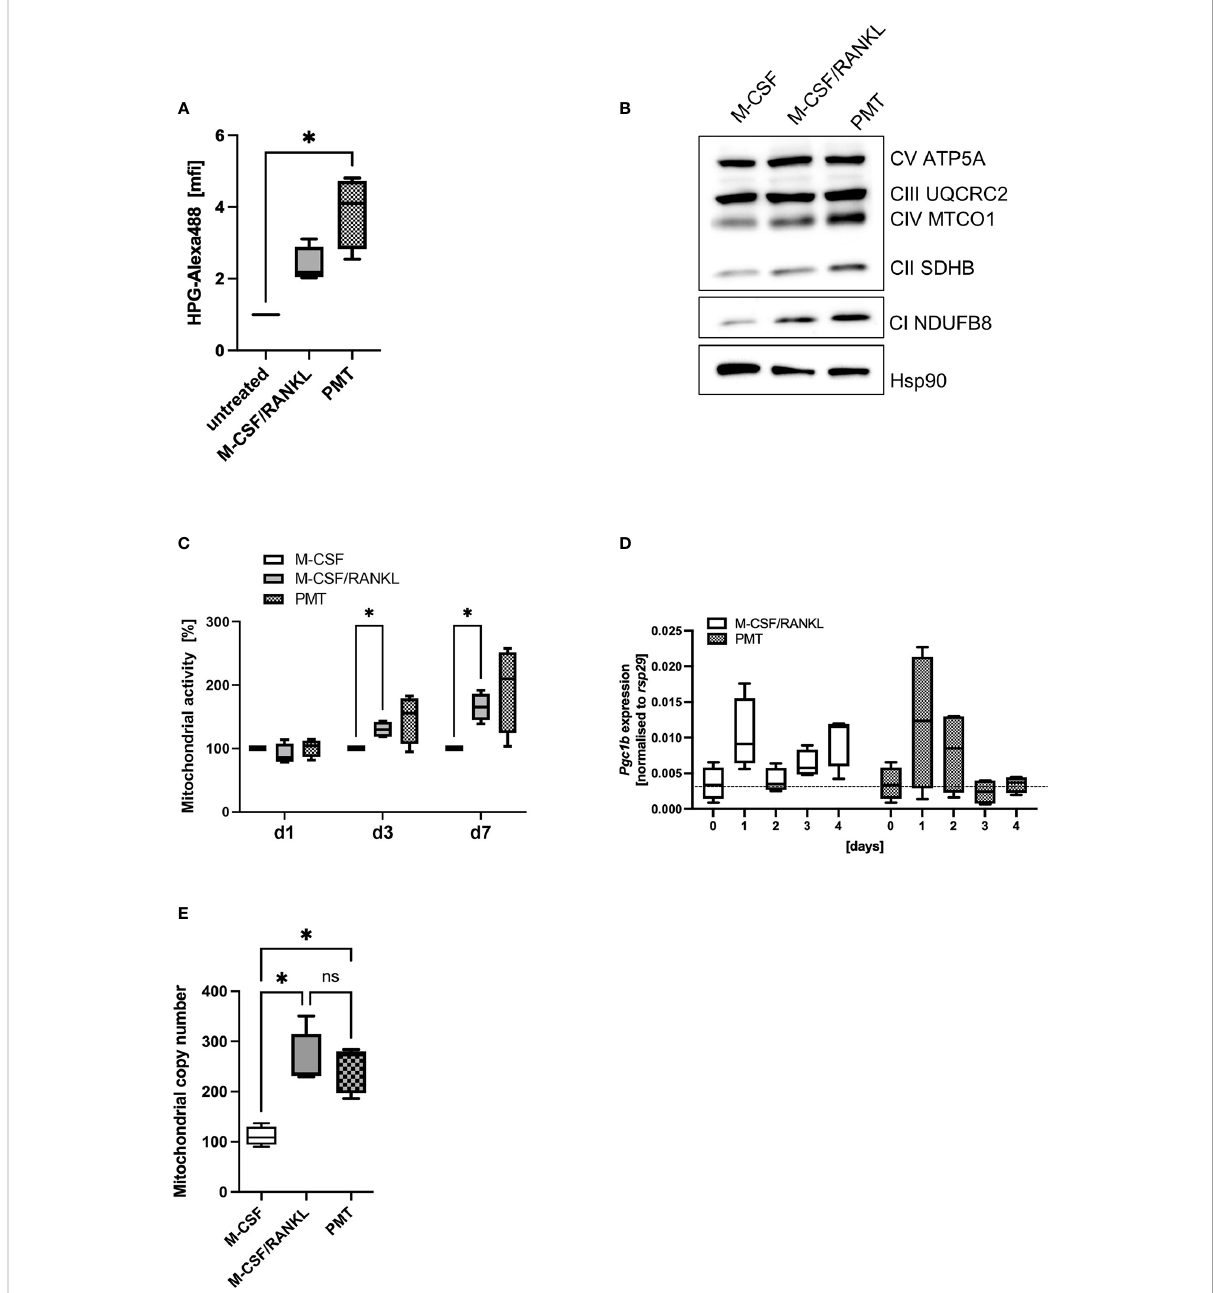
FIGURE 2 Mitochondrial activity during osteoclastogenesis. (A) Analysis of cellular translational activity using an HPG assay, were the methionine analogue HPG is coupled to Alexa488 on newly synthesised proteins (n=4). (B) Expression of OxPhos proteins on day 3 of differentiation of BMDM. Hsp90 was used as control (n=3). (C) To quantify mitochondrial activity, differentiating BMDM were incubated at the indicated days with Mitotracker Deep Red and fl uorescence intensity was quanti fi ed and normalised to the M-CSF control (n=4). (D) Expression of Pgc1b was investigated by RT-PCR in differentiating BMDM and normalised to the house-keeping gene rsp29 (n=4). (E) BMDM were differentiated into OCs for 4 days before preparing genomic DNA. Mitochondrial copy number was determined by RT-PCR comparing the expression of a mitochondria speci fi c sequence with nuclear DNA (n=5). Statistical analysis was done using a Friedman test for (A) on raw data before normalisation, 2-way ANOVA for (C) and (D) and Kruskal-Wallis for unmatched analysis for (E)